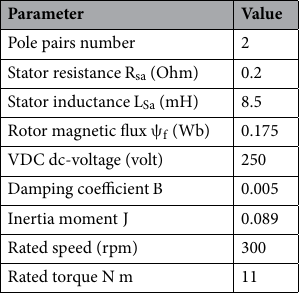
Table 2. Axial flux motor parameters.